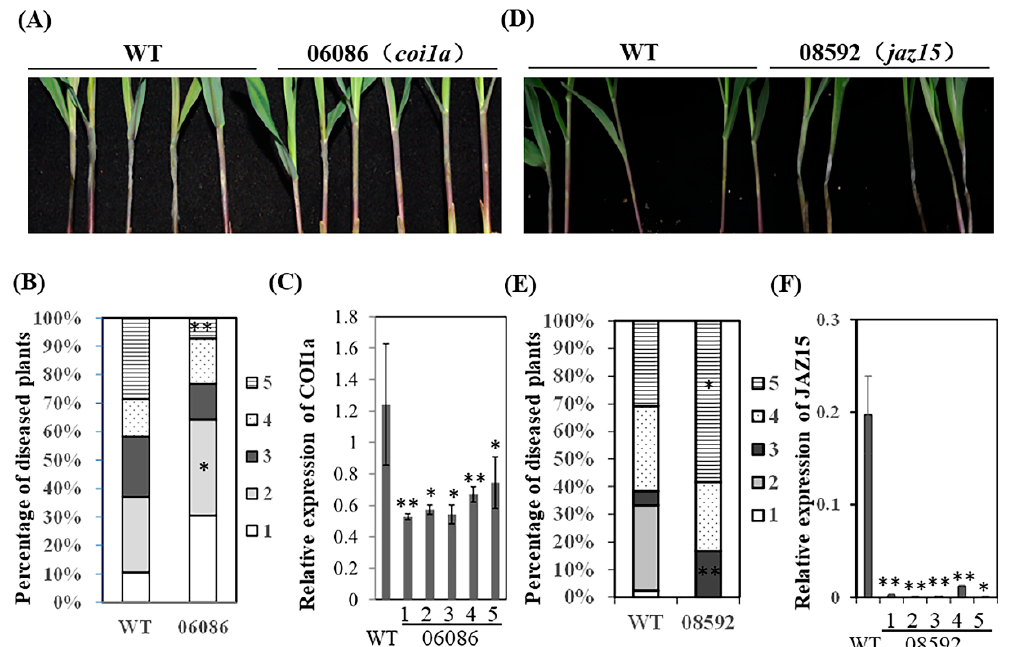
Figure 5. CRISPR-cas9 KO coi1a mutant is more resistant, whereas jaz15 mutant more susceptible to GSR. ( A ) GSR phenotypes of coi1a KO line and WT on 4 dpi. Only part of seedlings were shown in the picture. ( B ) the disease index distribution of each line. The disease index was recorded using level 1~5, in which 1 indicates the most resistant and 5 the most susceptible. The percentage of diseased plants was calculated based on the number of plants at each level over total plants. The star on the side of each level indicates the significance of difference of disease index in mutant over WT. ( C ) the expression levels of COI1a in different seedlings of line 06086. ( D ) GSR phenotypes of jaz15 KO line and WT on 4 dpi. Only part of seedlings were shown in the picture. ( E ) the disease index distribution of each line. The disease index was recorded using level 1~5, in which 1 indicates the most resistant and 5 the most susceptible. The percentage of diseased plants was calculated based on the number of plants at each level over total plants. The star on the side of each level indicates the significance of difference of disease index in mutant over WT. ( F ) the expression levels of JAZ15 in different seedlings of line 08592. The number under the bar on X-axis corresponds individual seedling shown in the picture in A . WT represents the average expression level from multiple seedlings. At least ten seedlings per line were tested for the phenotype and the experiments were replicated for three times with similar results. The statistical analysis was performed by T-test, and * and ** on the bars indicate significant differences between mutants and wild-type at p < 0.05 and p < 0.01 level,